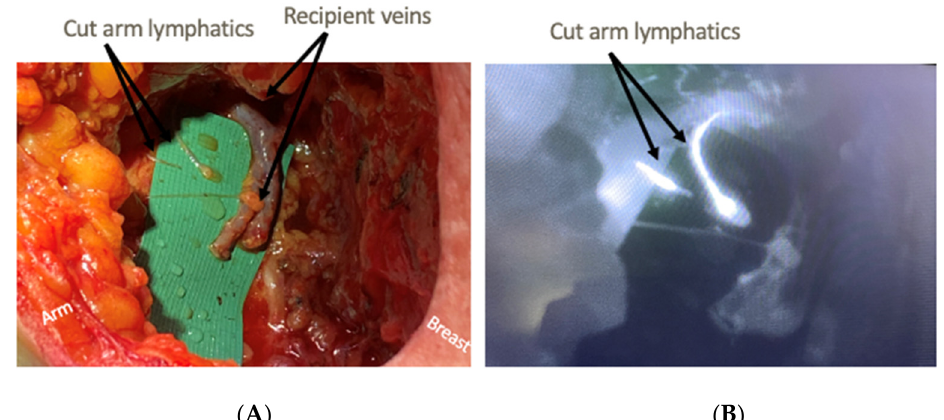
Figure 3. Preparation for LVA: ( A ) demonstrates two cut arm lymphatics and two nearby recipient veins, in this case branches of the pectoral vein. ( B ) demonstrates ICG and SPY correlate that shows bright lymphatics. The small structure in ( A ) that does not light up in ( B ) is a small nerve branch.